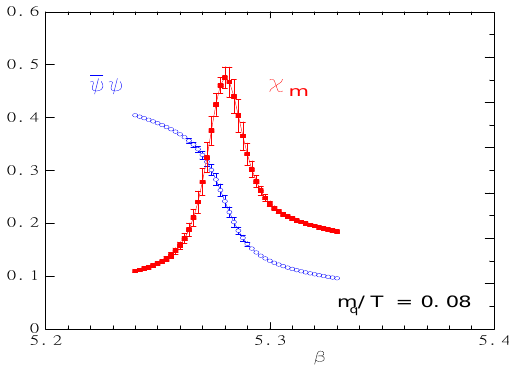
¯ ψψ is the order h i 0). The corresponding suscepti- →